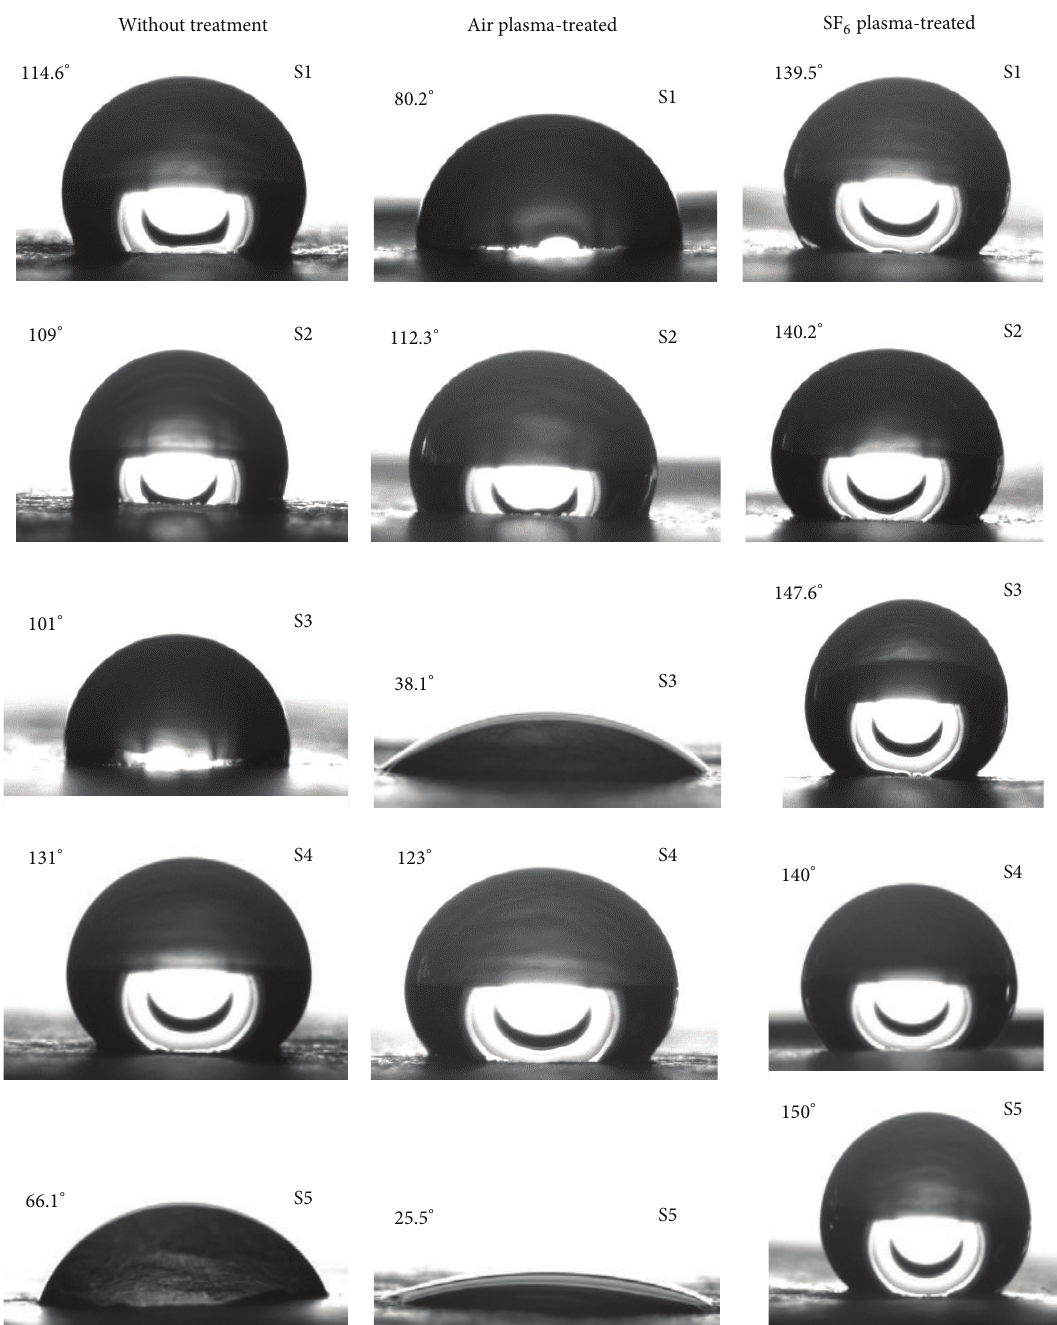
Figure 5: Changes in the contact angles of water droplets on the PAN, PVDF, and PVDF/PAN nanofibrous membranes without treatment and treated with air and with SF 6